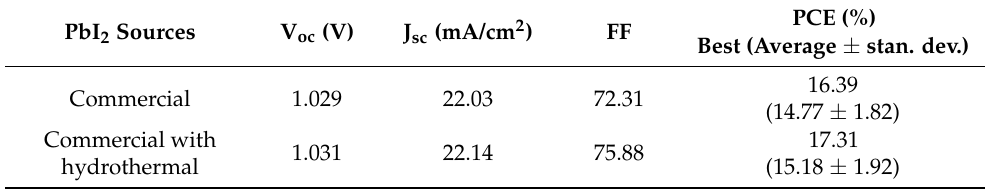
Figure S3: XRD patterns of PQDs, Figure S4: Photoluminescence spectra of PQDs made through as- synthesized PbI 2 , Figure S5: Historgrams about grain sizes of perovskite films, Figure S6: Precursor solution (DMF/DMSO mixed) with MAI and PbI 2 , Figure S7: A typical cross-sectional SEM image of perovskite layer for the PSCs whose performances were shown in Figure 5., Figure S8: UV- crystallized PbI 2 after